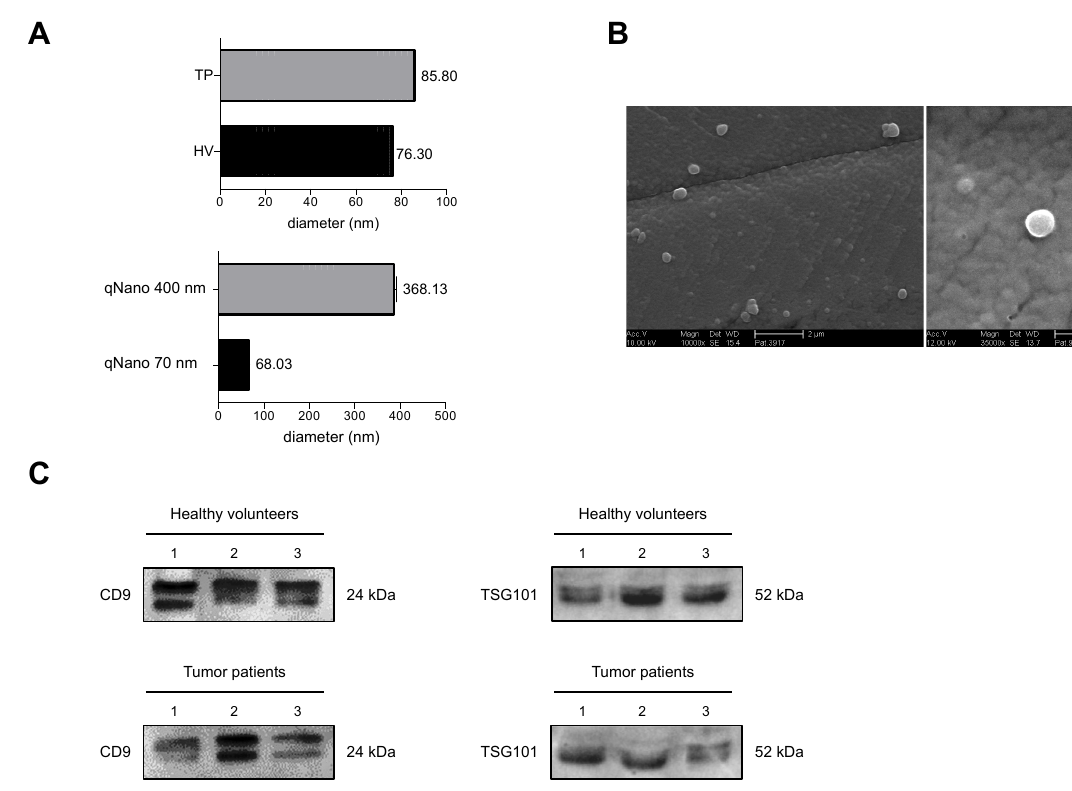
Figure 2. Assessment of the quality of isolated extracellular vesicles (EVs) from healthy volunteers (HV) and tumor patients (TP) one day before (pre T) and two days (post T) after selective internal radiotherapy radioembolization. ( A ) Representative DLS- size distribution profile of calibration nanoparticles and isolated EVs collected in HV and TP. ( B ) Scanning electron microscopy image of isolated EVs. The scale bar represents 2 µm, (10,000×; AccV. 10 kV) and 500 nm (35,000×; AccV. 12 kV) respectively. ( C ) Representative western blot assessing the protein content of isolated EVs from plasma of three different HV or TP (1–3) using genuine EVs markers CD9 and TSG101.